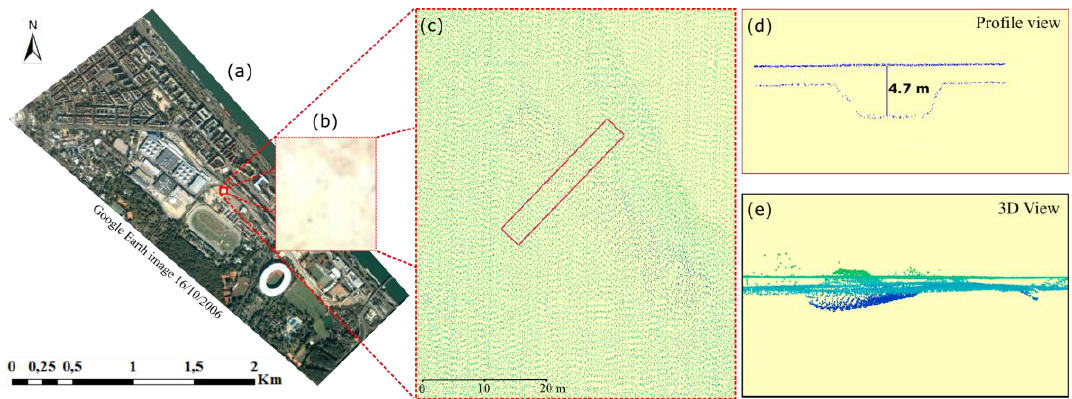
Figure 8. Open ground in the point cloud of 2007. Two contradicting layers of ground are shown due to construction activity within the duration of the 2007 campaign. ( a ) The Google earth image shows the location of the construction area; ( b ) orthophoto showing the selected area; ( c ) ground view of the point cloud indicates the position of the profile shown in sub-figure ( d ); and ( e ) a 3D view of the multilayer point cloud with the difference in height reaching 4.7 m.